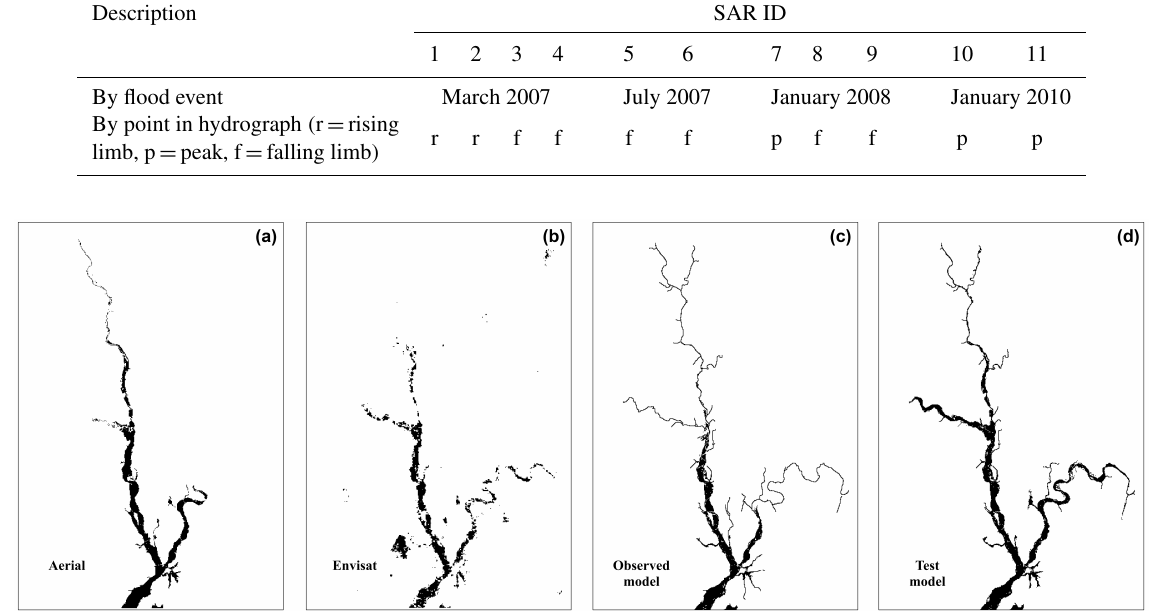
Table 3. Description of SAR groupings.